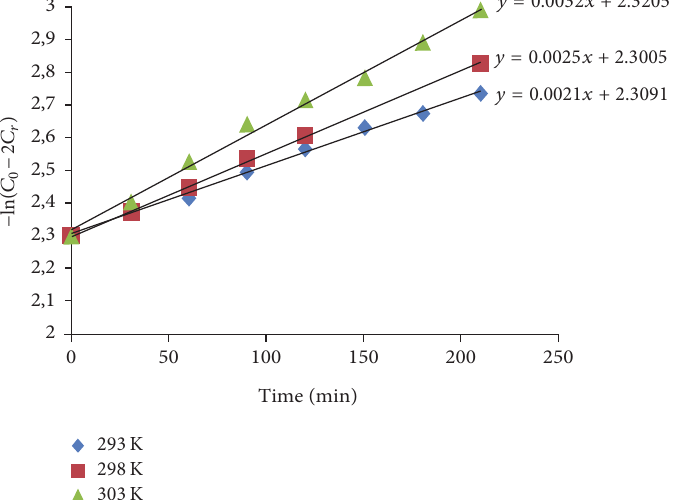
Figure 11: Temperature effect on − ln (𝐶 0 − 2𝐶 𝑟 ) term evolution versus time, for the facilitated extraction of VO 2+ ions by membrane SLM- RESO. [H 3 O + ] = 1M, [RESO] = 10 −2 M [VO 2+ ] =